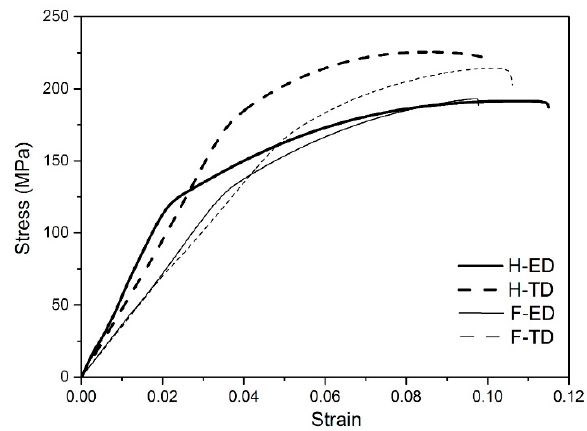
Figure 3. Tensile stress-strain curves of XK105. (H-ED: extrusion direction of XK105-H; H-TD: transverse direction of XK105-H; F-ED: extrusion of XK105-F; F-TD: transverse of XK105-F).